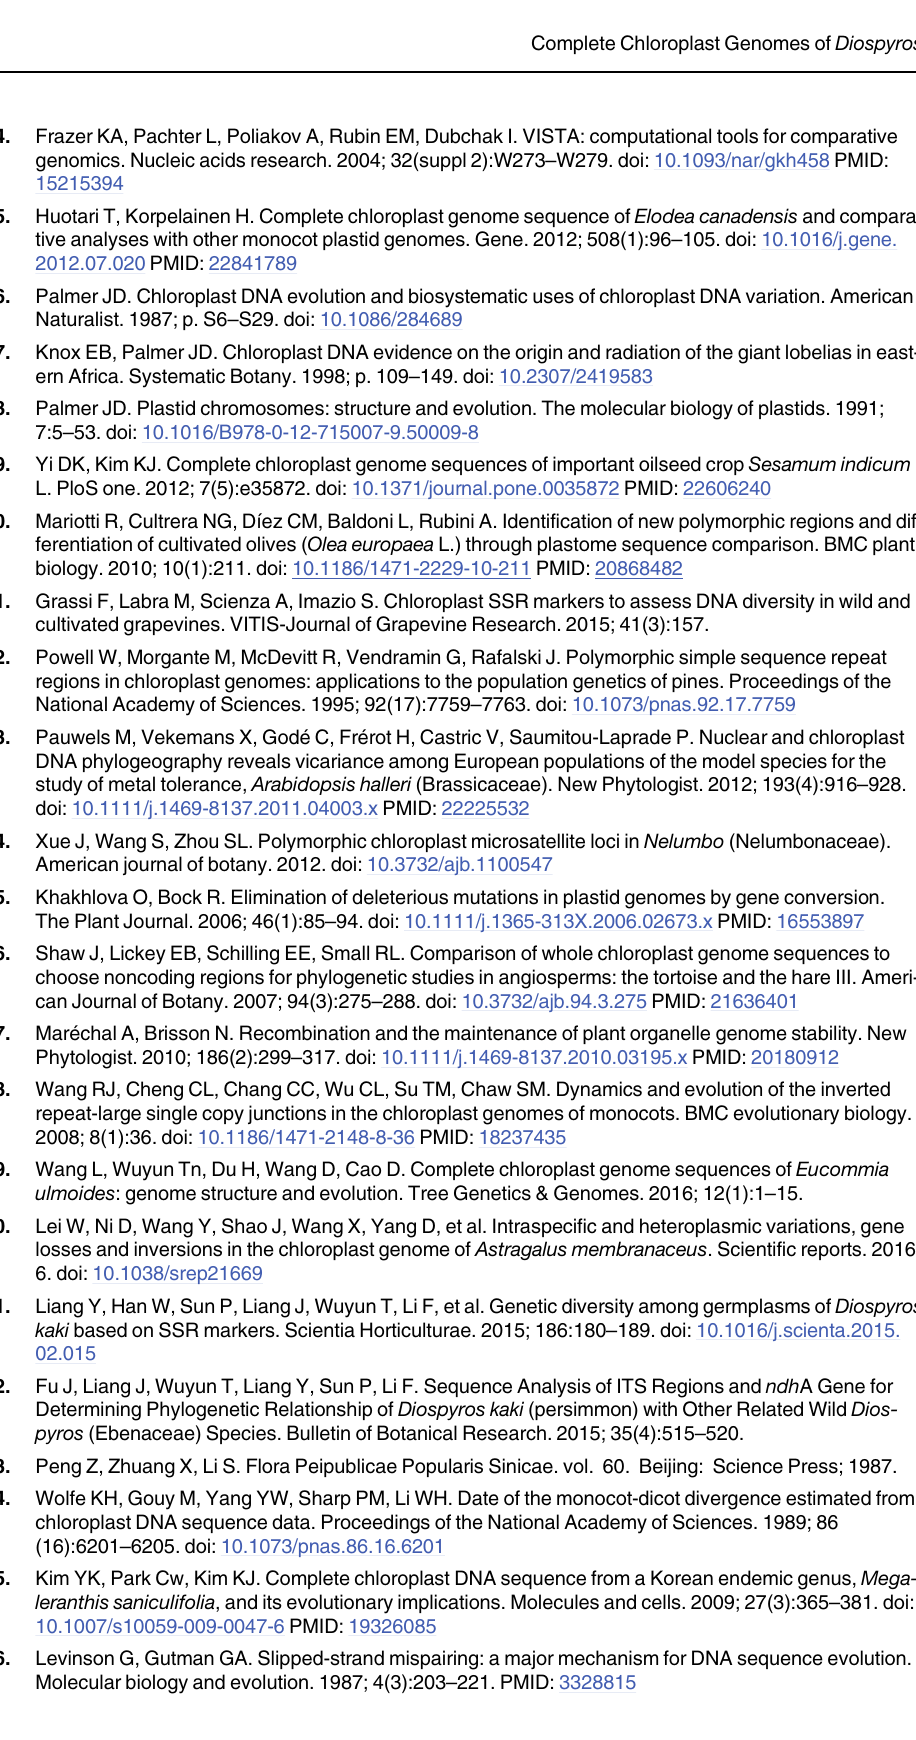
PLOS ONE | DOI:10.1371/journal.pone.0159566 July 21,